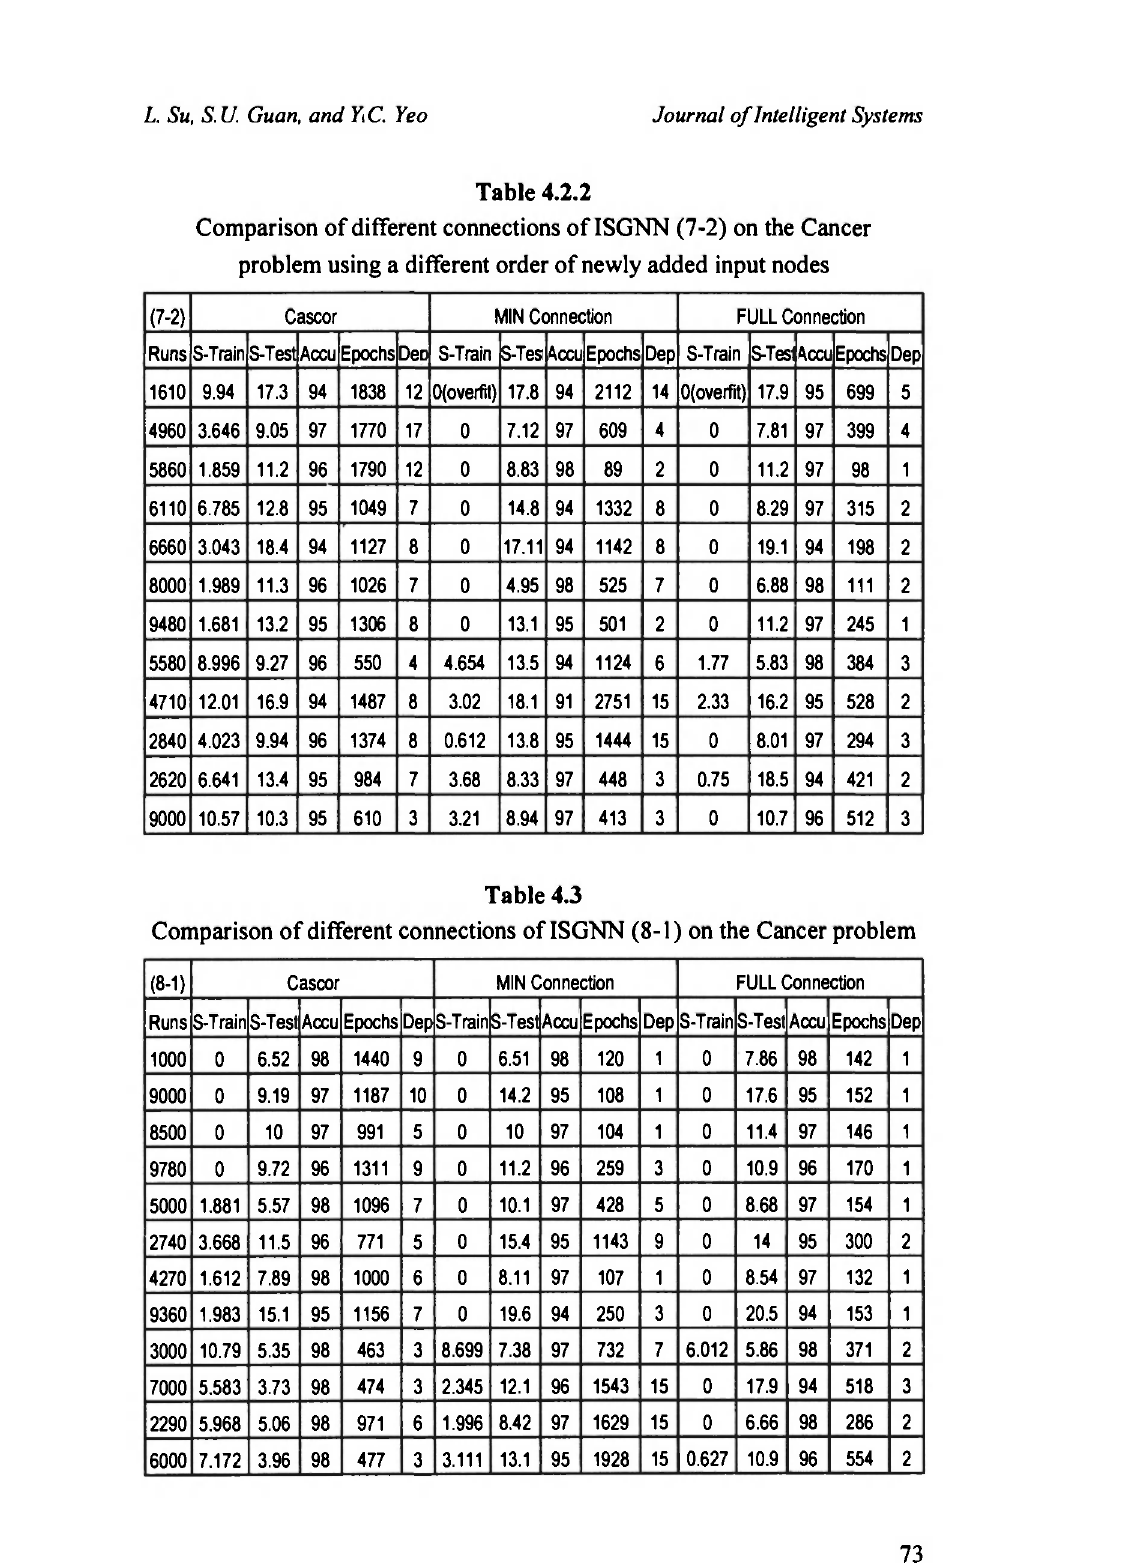
Comparison of different connections of ISGNN (8-1) on the Cancer problem Cascor MIN Connection FULL